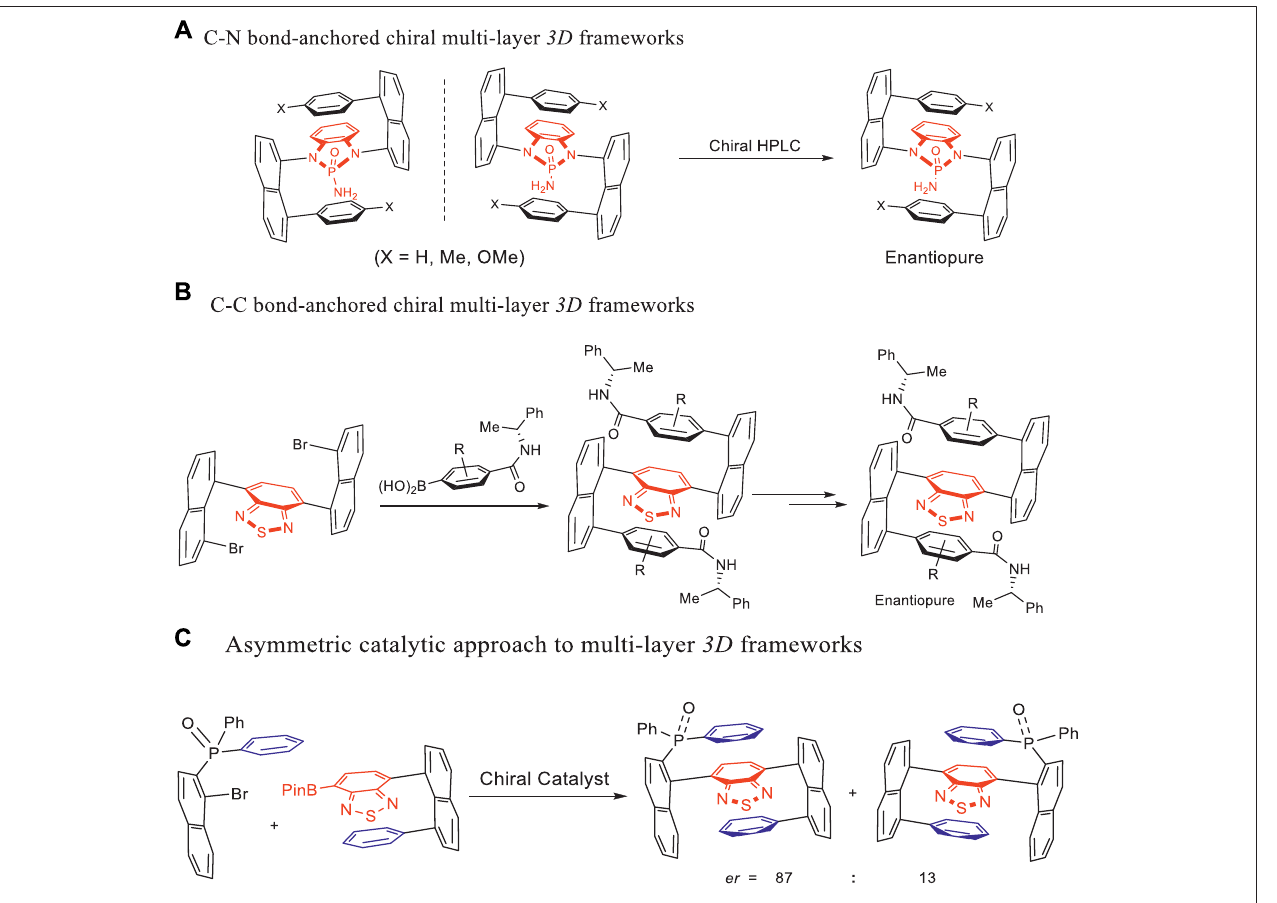
FIGURE 1 | Strategy and progress of assembling multilayer 3D chirality. (A) C – N bond – anchored chiral multilayer 3D frameworks. (B) C – C bond – anchored chiral multilayer 3D frameworks. (C) Asymmetric catalytic approach to multilayer 3D frameworks.